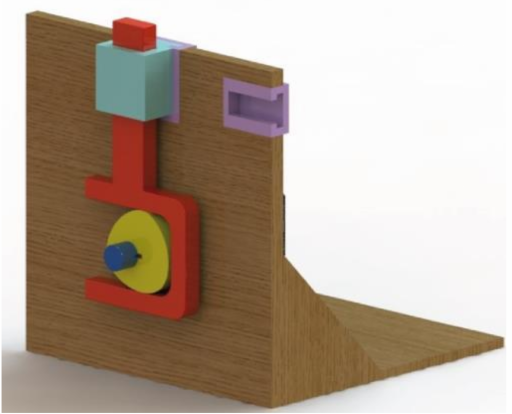
Figure 9. A virtual model of the assembled cam–follower mechanism.